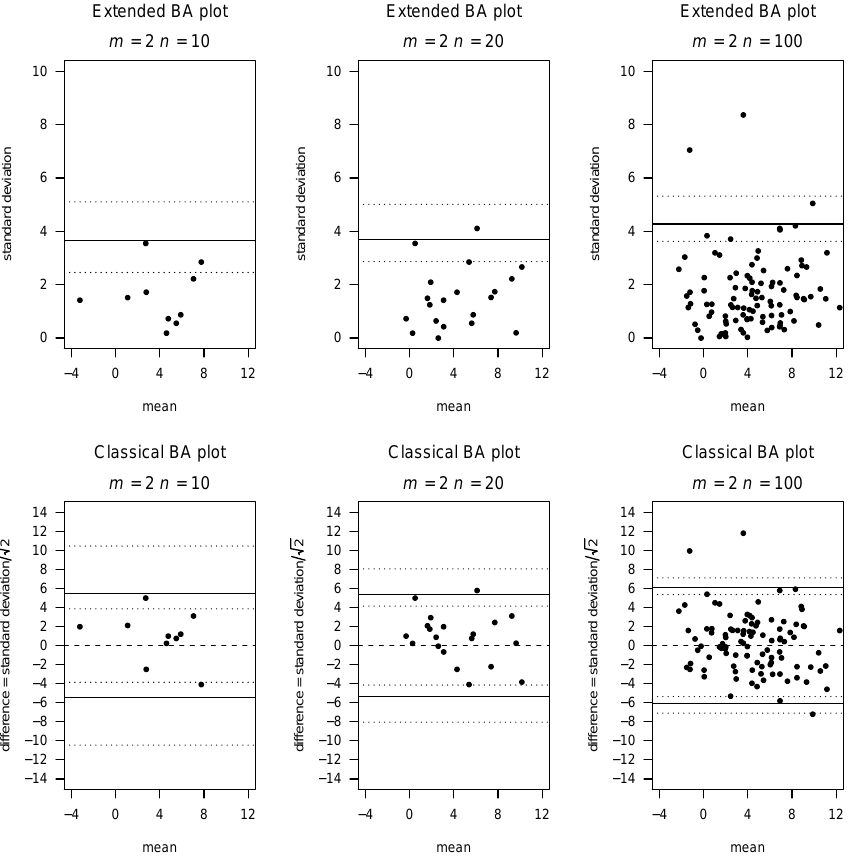
Figure 1. Comparison between the extended and classical BA plot for 2 raters based on simulated data with a true standard deviation σ =